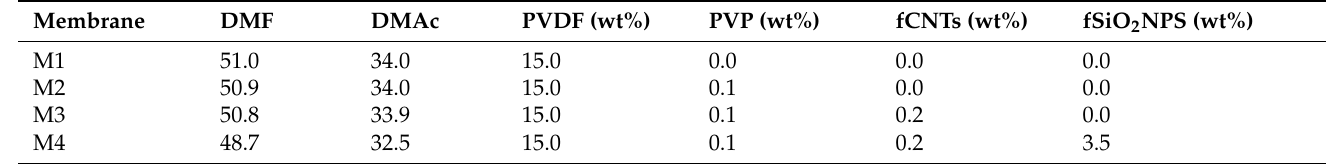
Table 1. Composition of the as-synthesised